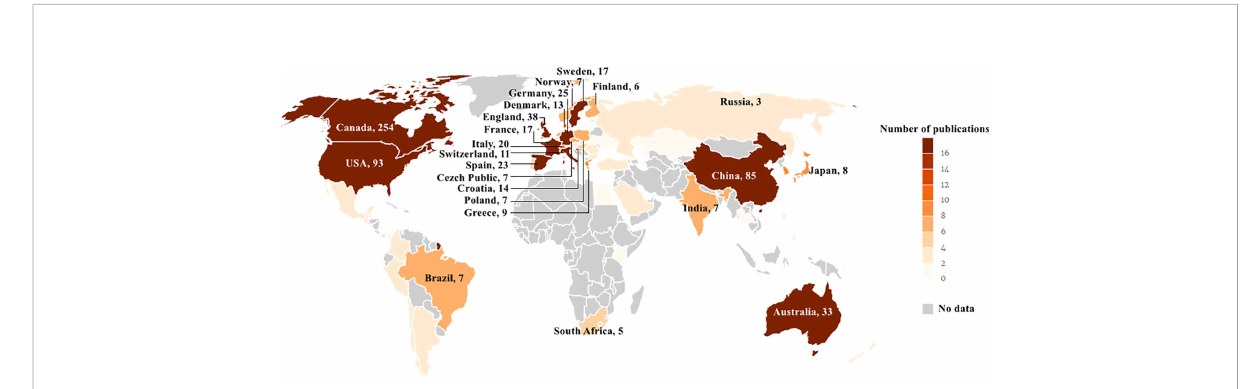
FIGURE 3 Geographical distribution of article publications related to RNA methylation in DM and its complications. The label represents the country and the outputs of the country; the depth of color matched with the number of